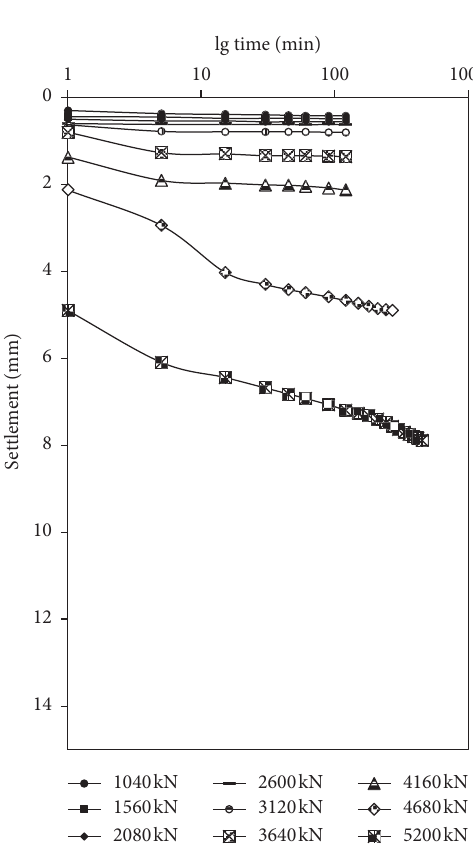
Figure 10: Ten Q-s curves of the tested